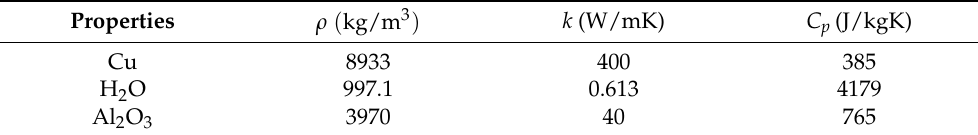
Table 2. Base fluid and nanoparticle properties (see Oztop and Abu-Nada